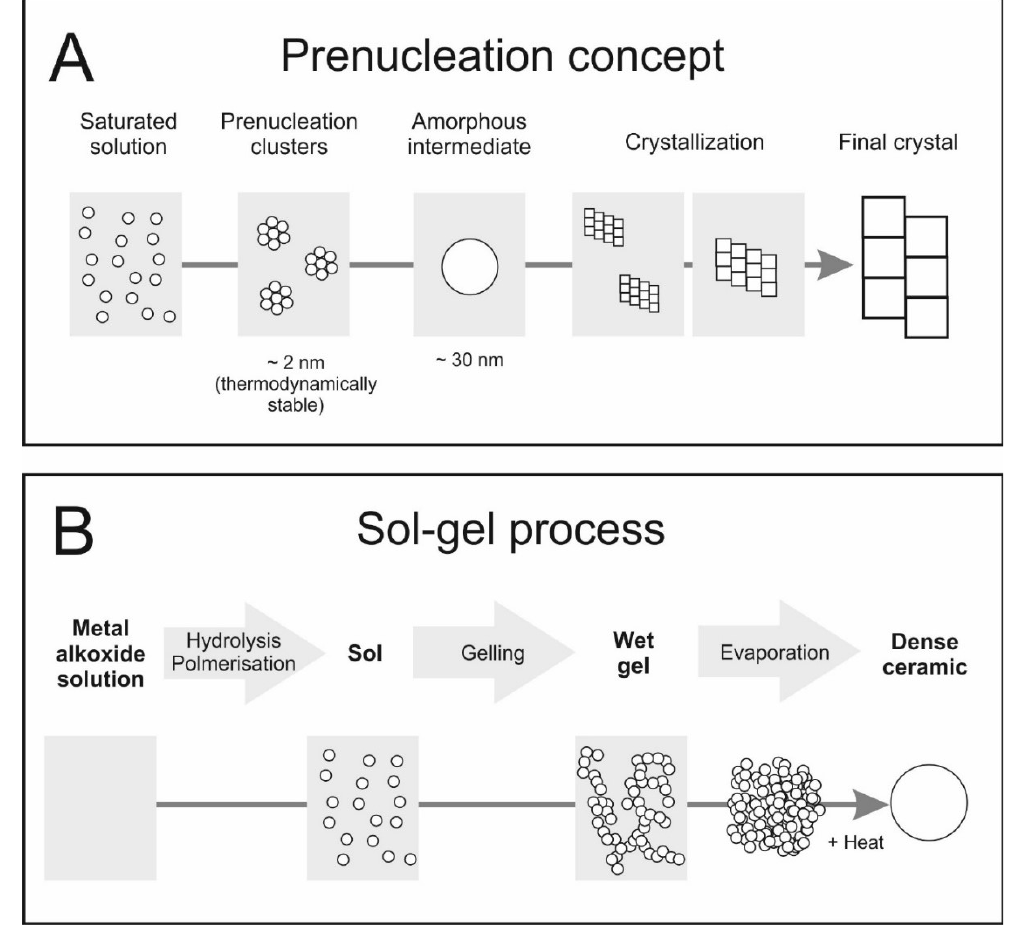
Figure 1. ( A ) Nonclassical pathway for the growth of crystalline materials from solutions. ( B ) Scheme representing the evolution of aqueous silica system from monomers to developed sols and gels, in relation to reaction conditions. ( A ) is redrawn after Figure 5.2 in Reference [29]; see details for references therein. ( B ) Various steps in the sol-gel process to control the final morphology of the product (redrawn after Figure 2.1. in Reference [30]).